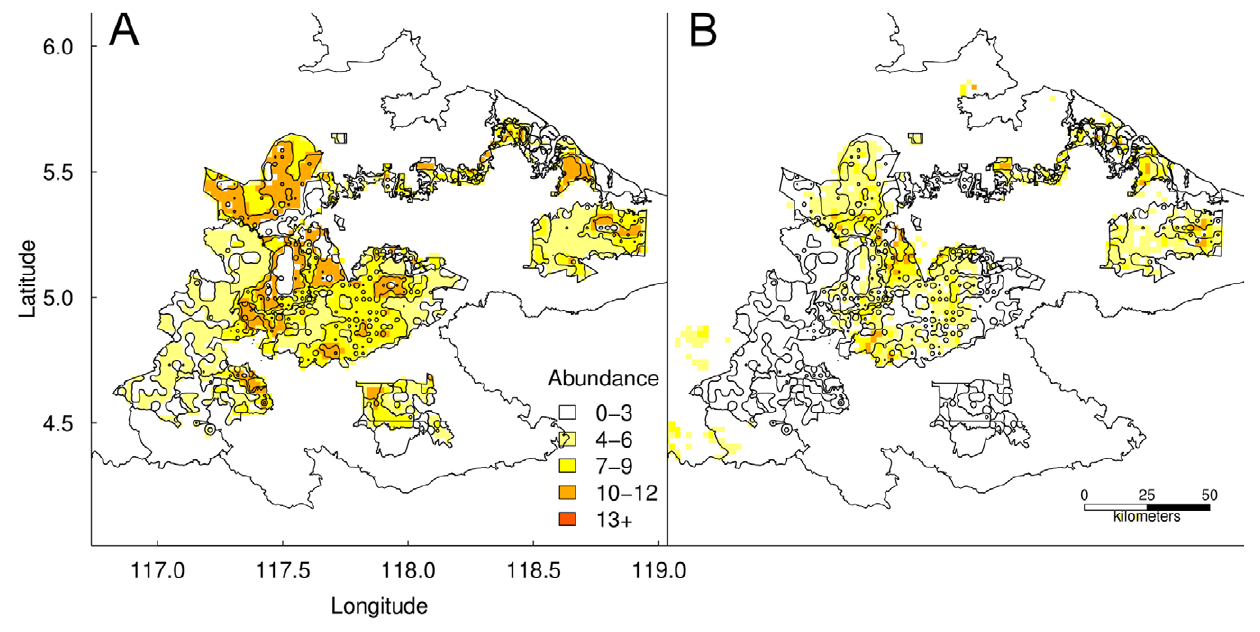
Figure 3. Validation of predicted nest counts on an independent orangutan nest count dataset. Maps showing the spatial correspondence between orangutan nest counts calculated from (a) [25] and (b) our model predictions. Note that the model-predicted nest counts are generally lower than the empirically derived estimates.